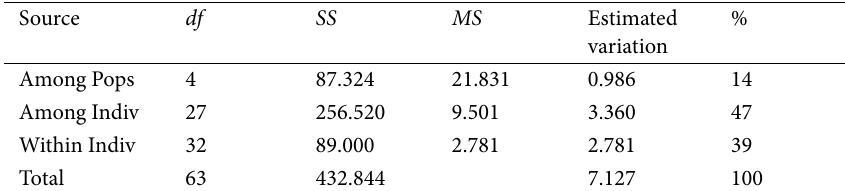
Table 3 Analysis of molecular variance (AMOVA) using 26 molecular markers of the genetic variation of the 32 barley lines.